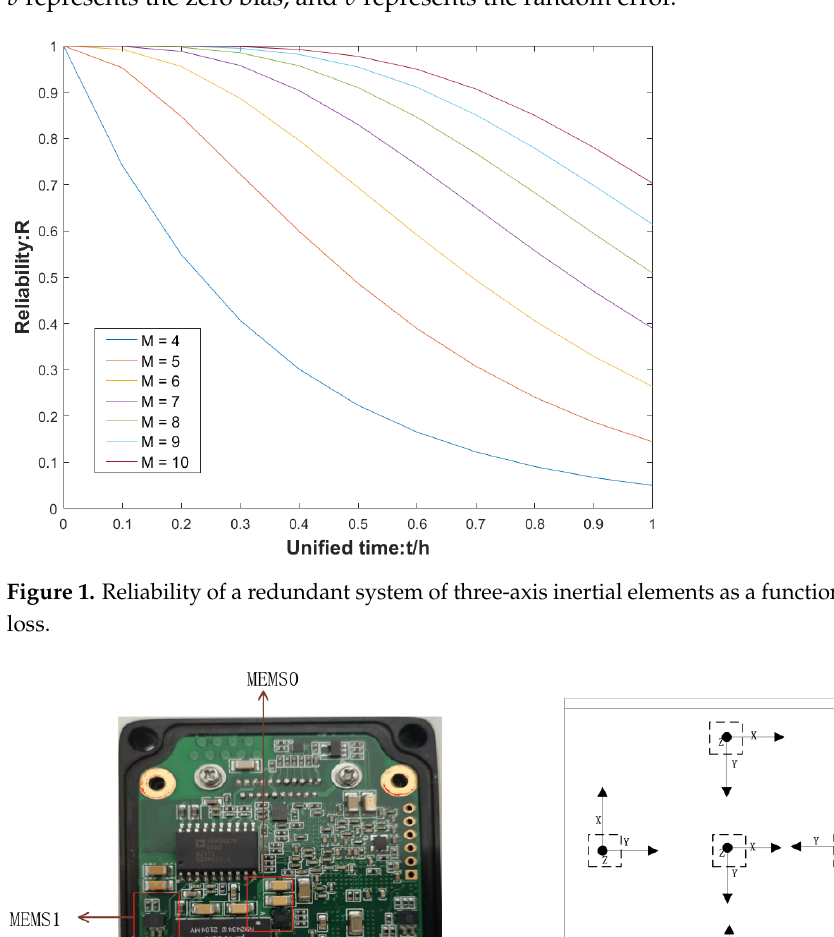
a B is the ratio in the orthogonal coordinate system represented, a S represents the ratio in the non-orthogonal coordinate where the superscript a represents the accelerometer, g represents the gyroscope, i represents the i -th sensor, and B represents the orthogonal reference coordinate system. S represents the transformation matrix of the axis deviations, K represents the scale a ω represents the true value of the output of the i -th accelerometer and factor, and , s s i i gyroscope. b represents the zero bias, and v represents the random error.